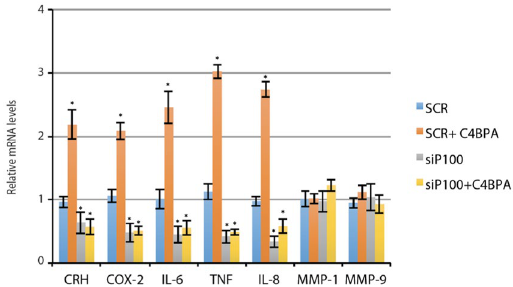
Figure 5. C4BPA induces expression of labor drivers in the human placenta. Term CTB were transfected with siRNA targeting p100 (siP100, which were in turn exposed to C4BPA for additional 24 hr. mRNA levels of CRH, COX-2, IL-6, TNF, IL-8, MMP-1, or MMP-9 were analyzed by means of RT-qPCR (N = 3 individual experiments). The bars represent average of relative mRNA levels and standard deviation from 3 individual experiments. * p <